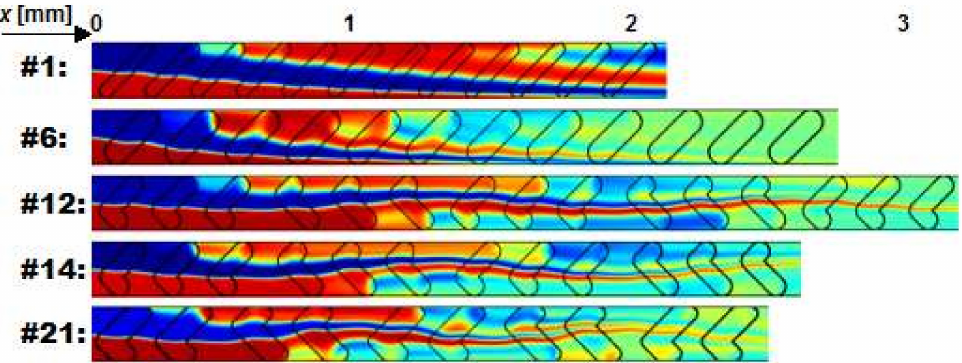
Figure 11. Results of mixing simulations for di ff erent BGM designs represented by a concentration surface in the mid-plane of the main channel. Operation conditions are defined by Re = 3 and Pe = 3670. Green colour denotes complete